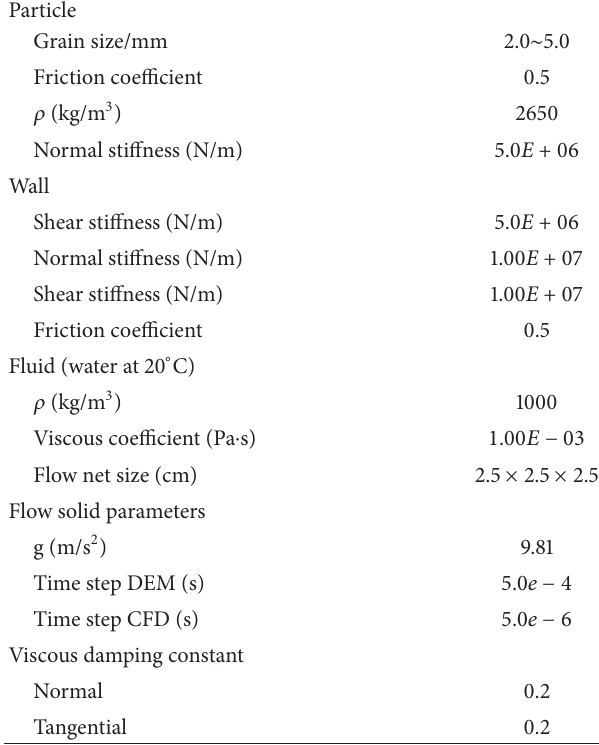
Table 3: The coefficient of numerical